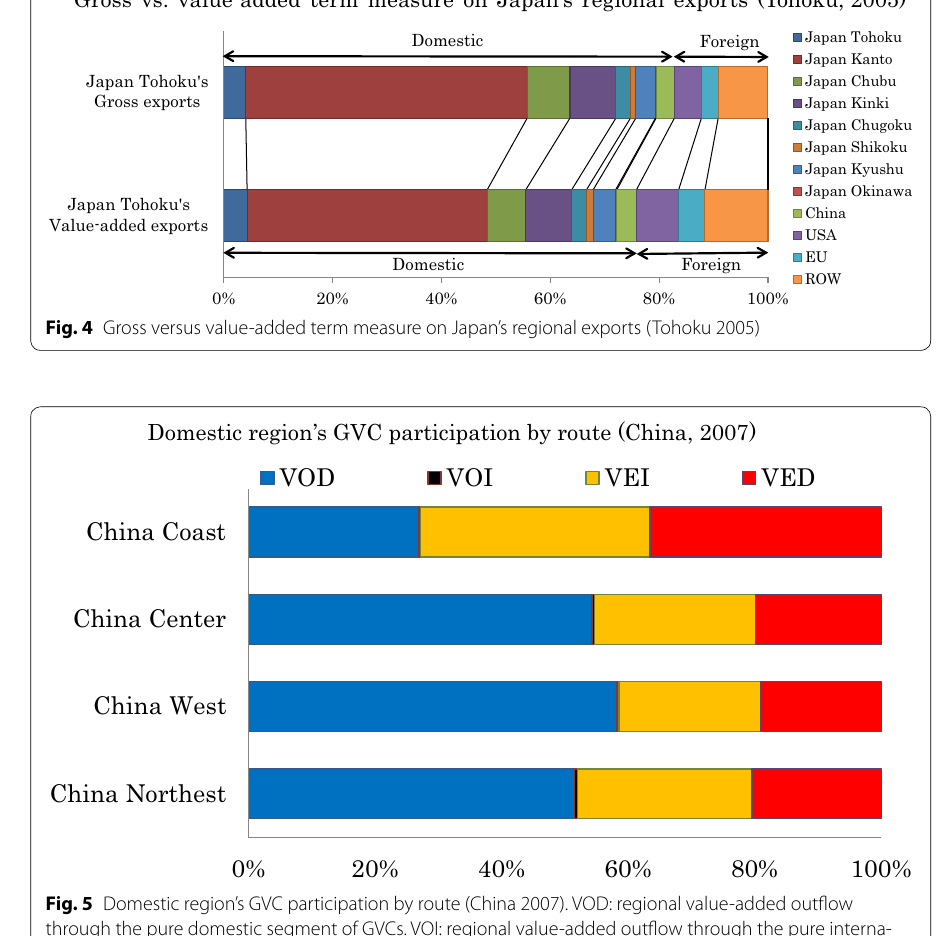
Gross vs. value-added term measure on Japan’s regional exports (Tohoku, 2005)